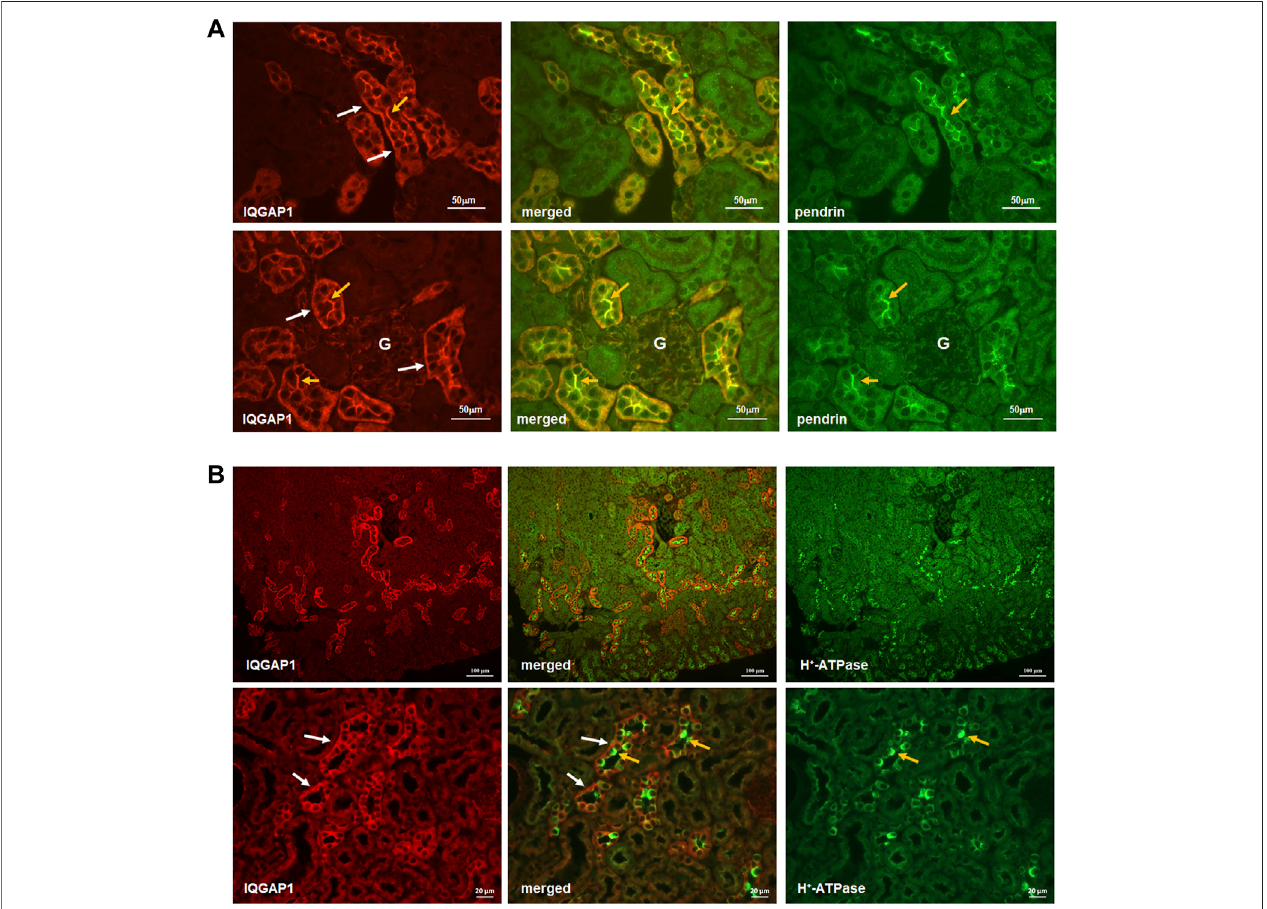
FIGURE 2 | Co-localization IQGAP1, pendrin, and H + -ATPase in the kidney by immuno fl uorescence microscopy. (A) Top and bottom panels are immuno fl uorescencedoublelabelingofmousekidneysectionswithanti-IQGAP1andanti-pendrinantibodies(×40magni fi cation).TheexpressionofIQGAP1isdetected on the basolateral membrane in the of majority of cells in the CCD (Left Panels, top and bottom rows; white arrows). In addition, IQGAP1 shows apical localization in a subset of cells in CCD (Left Panels, top and bottom rows; orange arrows). The expression of pendrin is shown in right panels (orange arrows). Merged images (middle panels) demonstrates a remarkable co-localization of IQGAP1 and pendrin on the apical membrane of pendrin-expressing cells (orange arrows). “ G ” signi fi es glomerulus. (B) To determine the identity of tubular cells expressing IQGAP1, double immuno fl uorescence labeling with IQGAP1 and H + -ATPase antibodies was performed. As shown, IQGAP1 was detected in several cortical collecting duct and connecting tubules based on the presence of H + -ATPase, tubular morphology, and whenthemerged imageswereacquired (middleimages inboth topand bottom panels). There wasoccasionaland faint expression ofIQGAP1 onthebasolateral mem- brane of the proximal tubule cells. In cortical collecting duct (CCD), IQGAP1 shows predominant localization on the basolateral membrane of most cells (bottom panels; white arrows). However, IQGAP1 also shows distinct localization on the apical membrane of a subset of intercalated cells (bottom panels; yellow